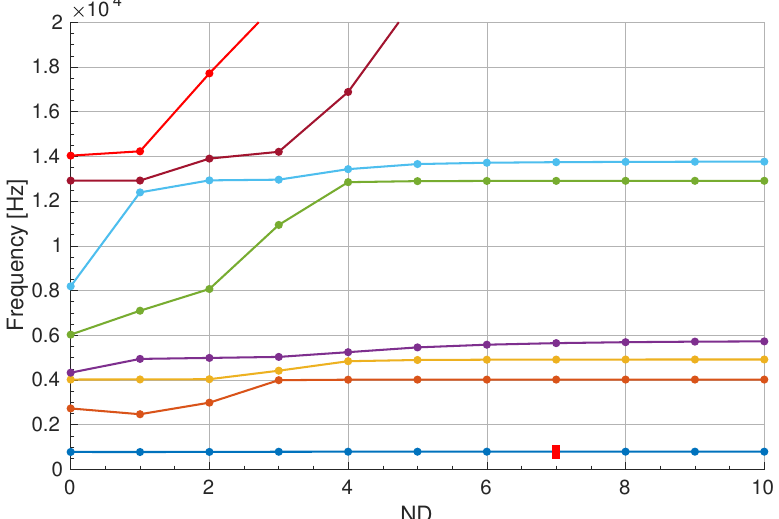
Figure 11. Rotor B natural vibration frequencies. Red thick line indicates the forcing case considered with engine order EO =